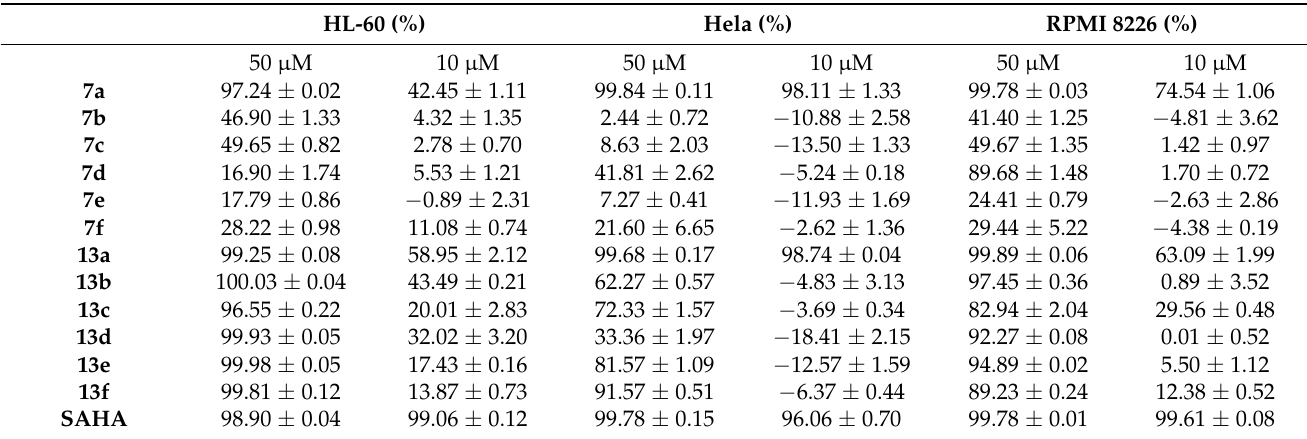
Table 1. Inhibition rate of target compounds in different cell